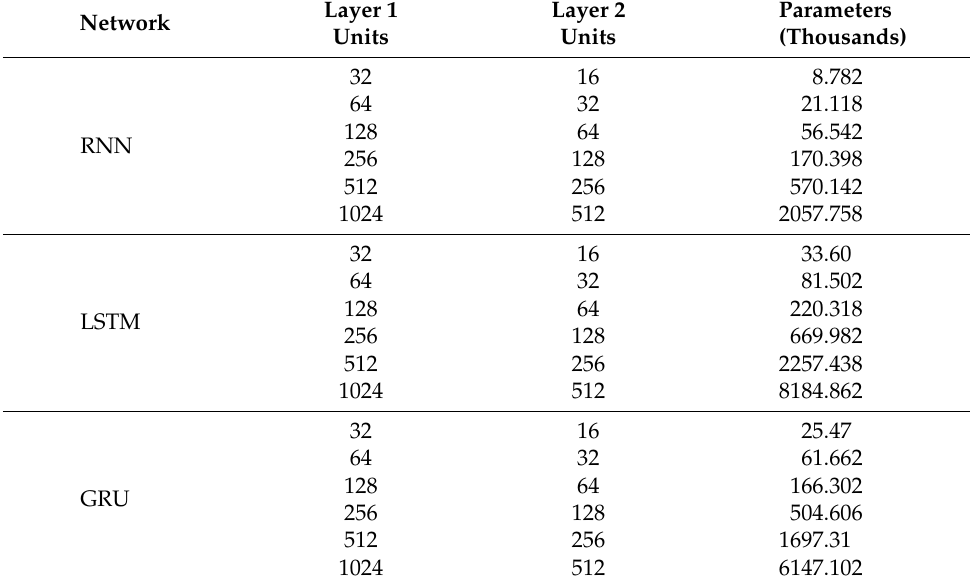
Table 3. Model variations used for